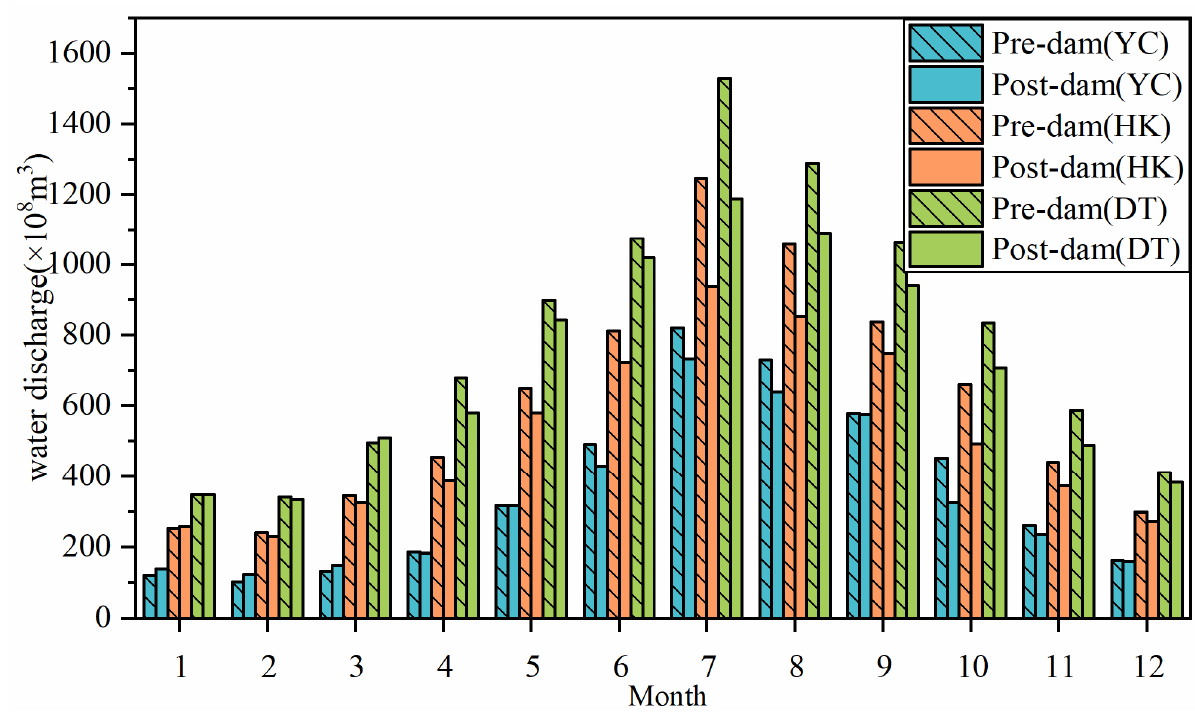
Figure 8. Monthly averaged water discharges in three key gauging stations (YC: Yichang; HK: Hankou; and DT: Datong) in the pre-dam (1989–2002) and post-dam (2003–2017) periods.